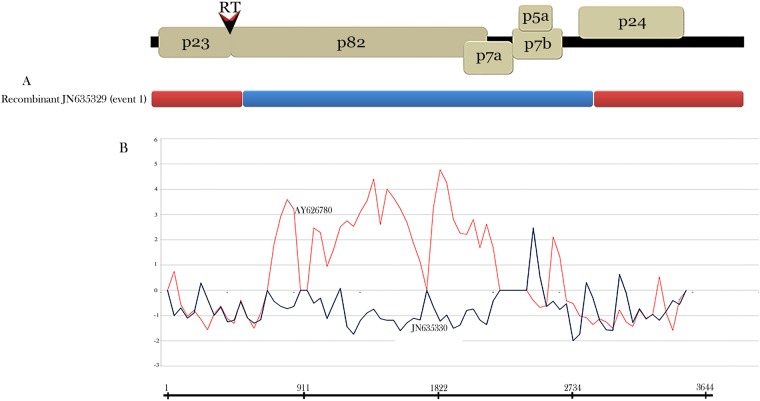
The genome organization of Beet black scorch virus is shown at the top of the figure.(A) The schematic recombination event 1 is shown for isolate Xinjiang/m81 (JN635329). Major and minor parents are indicated by Red and Blue boxes. (B) Graph showing SISCAN v.2 analysis of the recombinant Xinjiang/m81 isolate (JN635329) with the Xinjiang (AY626780) (Red color) and Xinjiang/m294 (JN635330) (Blue color) as the putative major and minor parents, respectively.